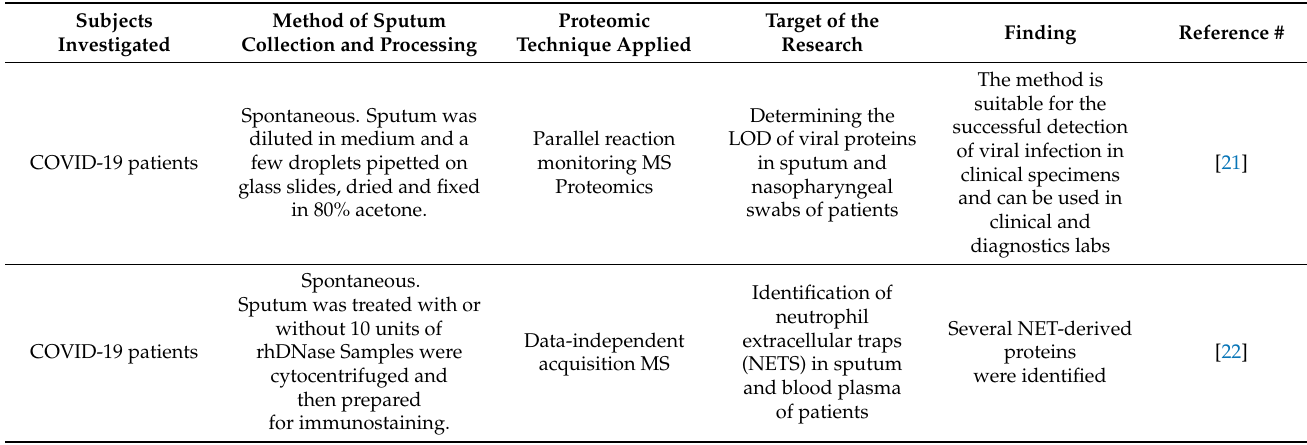
Table 1. List of articles on proteomics of sputum in COVID -19